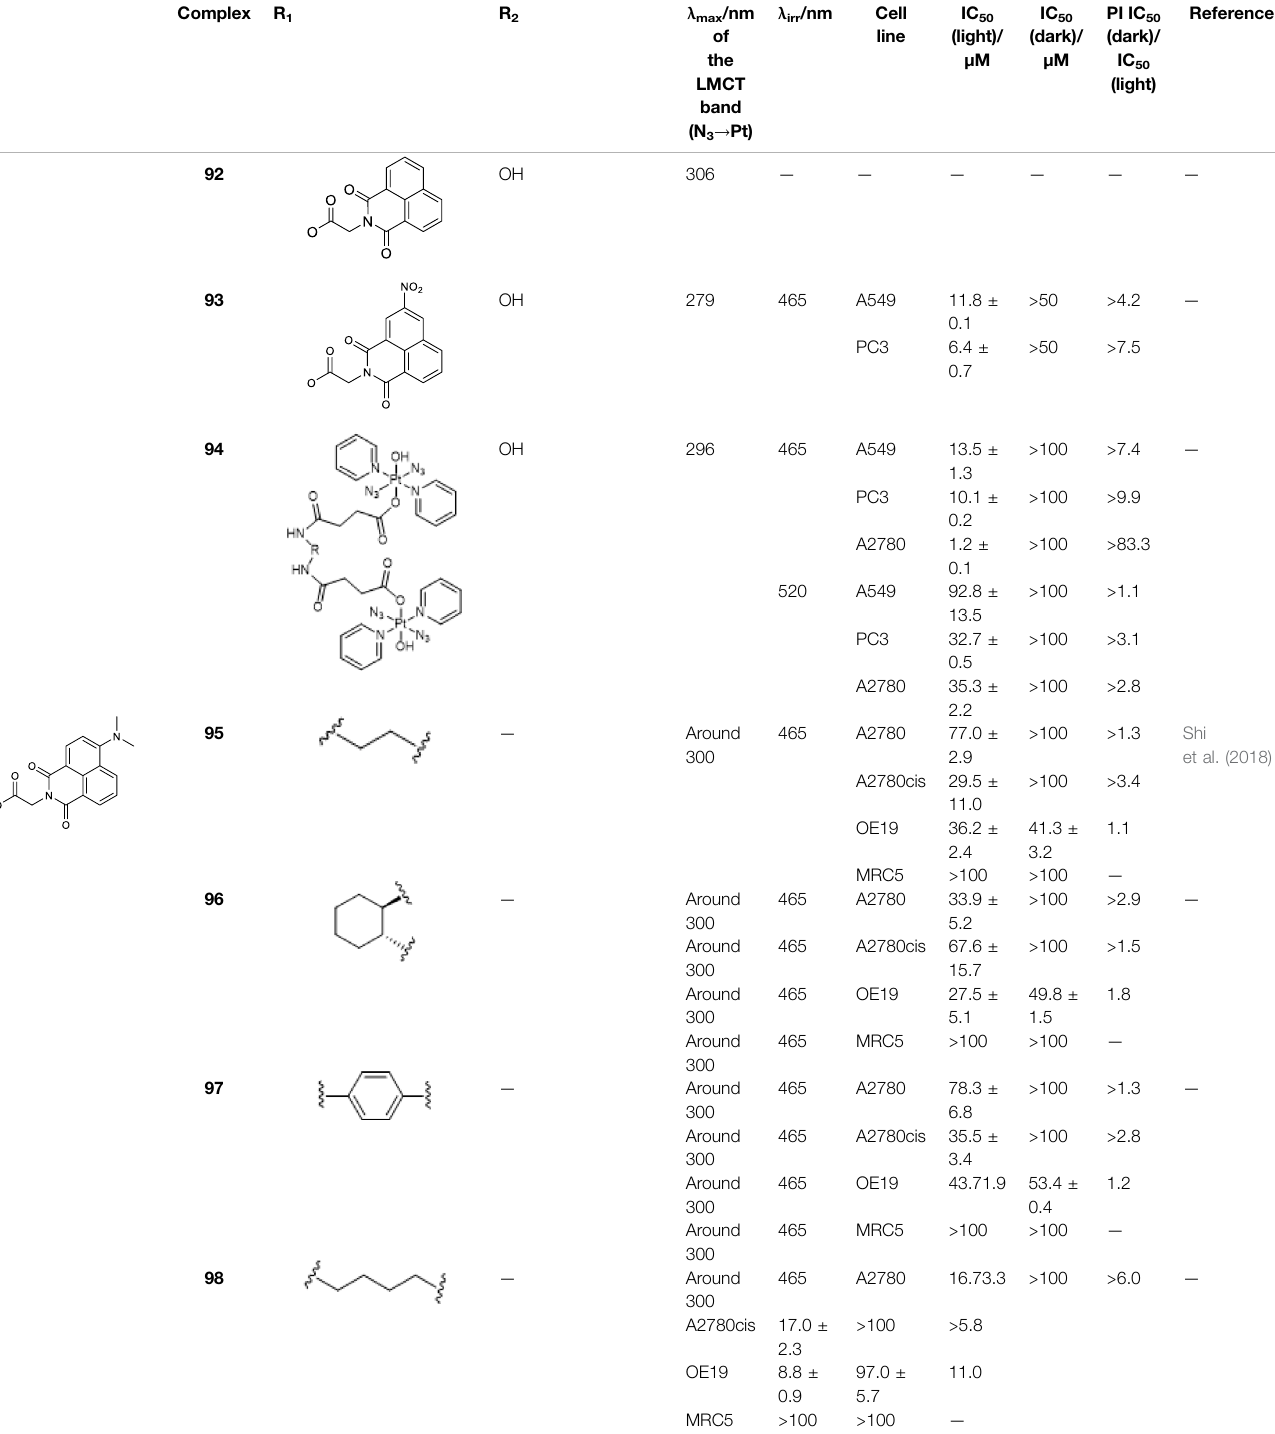
TABLE 8 | ( Continued ) Chemical structures of complexes 81 – 94 and IC 50 values of complexes toward different cell